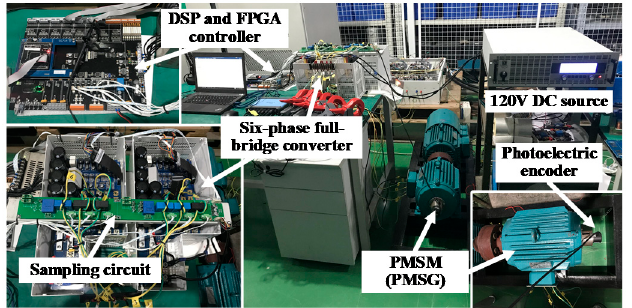
An experimental platform is designed as shown in Figure 12.